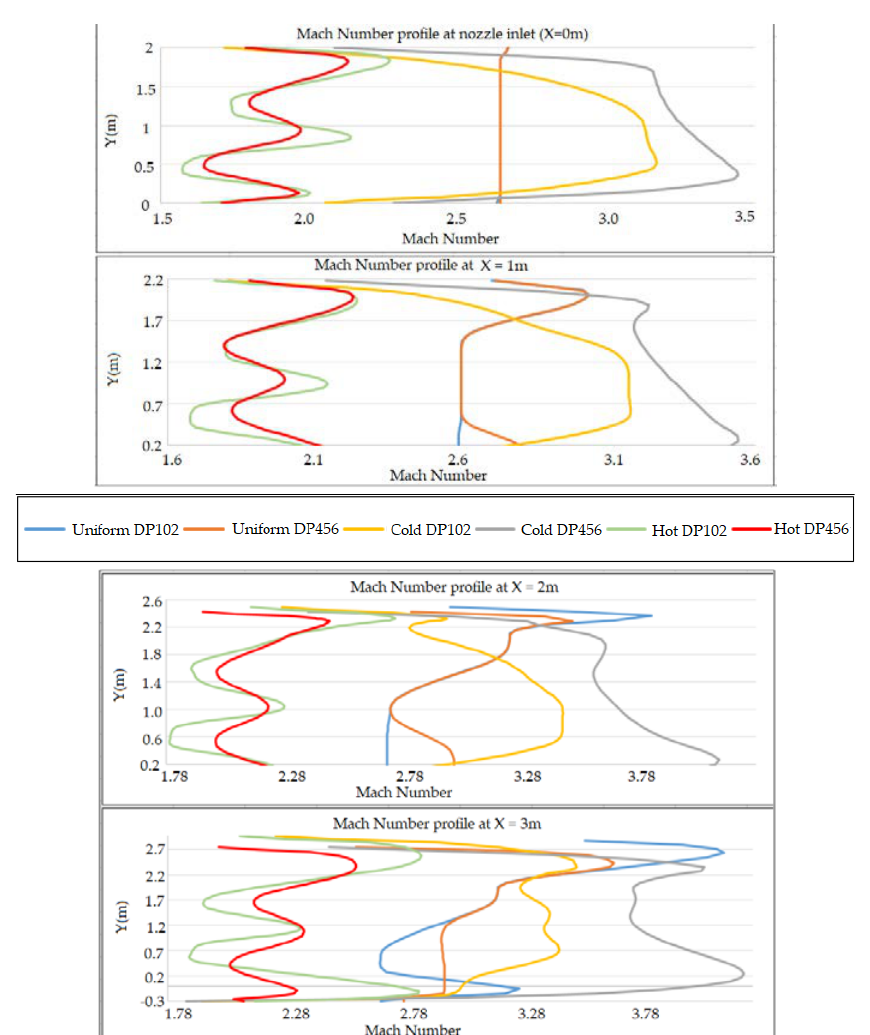
Figure 18. Mach number profiles for different cases at distances (from top to bottom ) of: 0 m, 1 m, 2 m, and 3 m from the nozzle inlet.